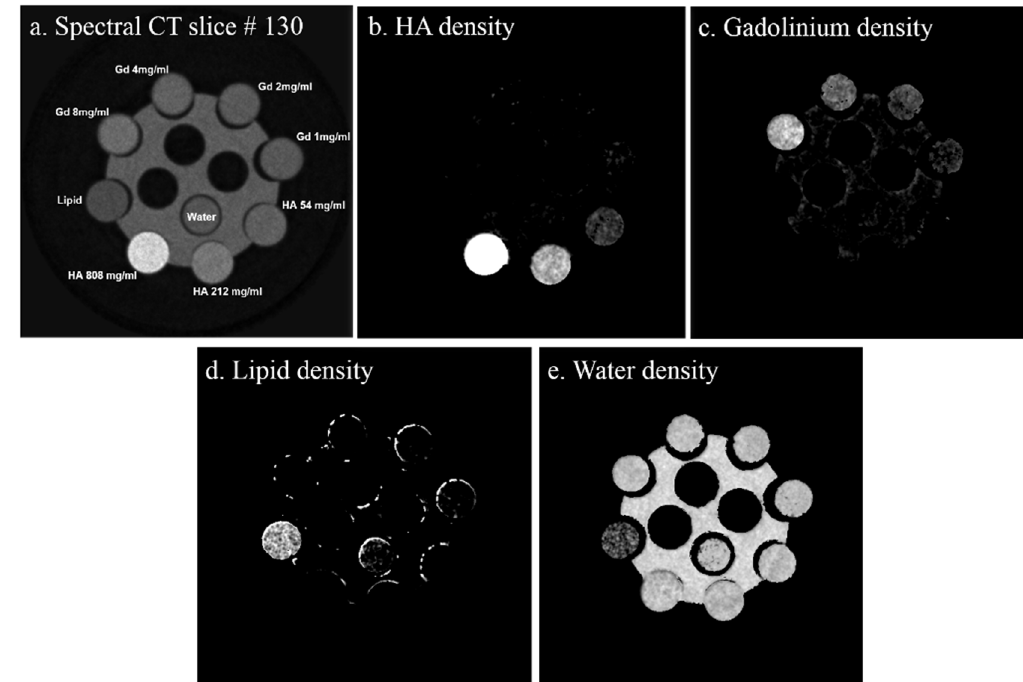
Figure 8. Identification of a spectral CT image into individual elements using protocol ‐ 1. Top ( a – c ): spectral CT image with one of the energy bins (30–45 keV), an image with only HA density, and an image with only gadolinium density. Bottom ( d , e ): image with lipid density and an image with only water density. The window levels are normalized from 0 to 1 for display.